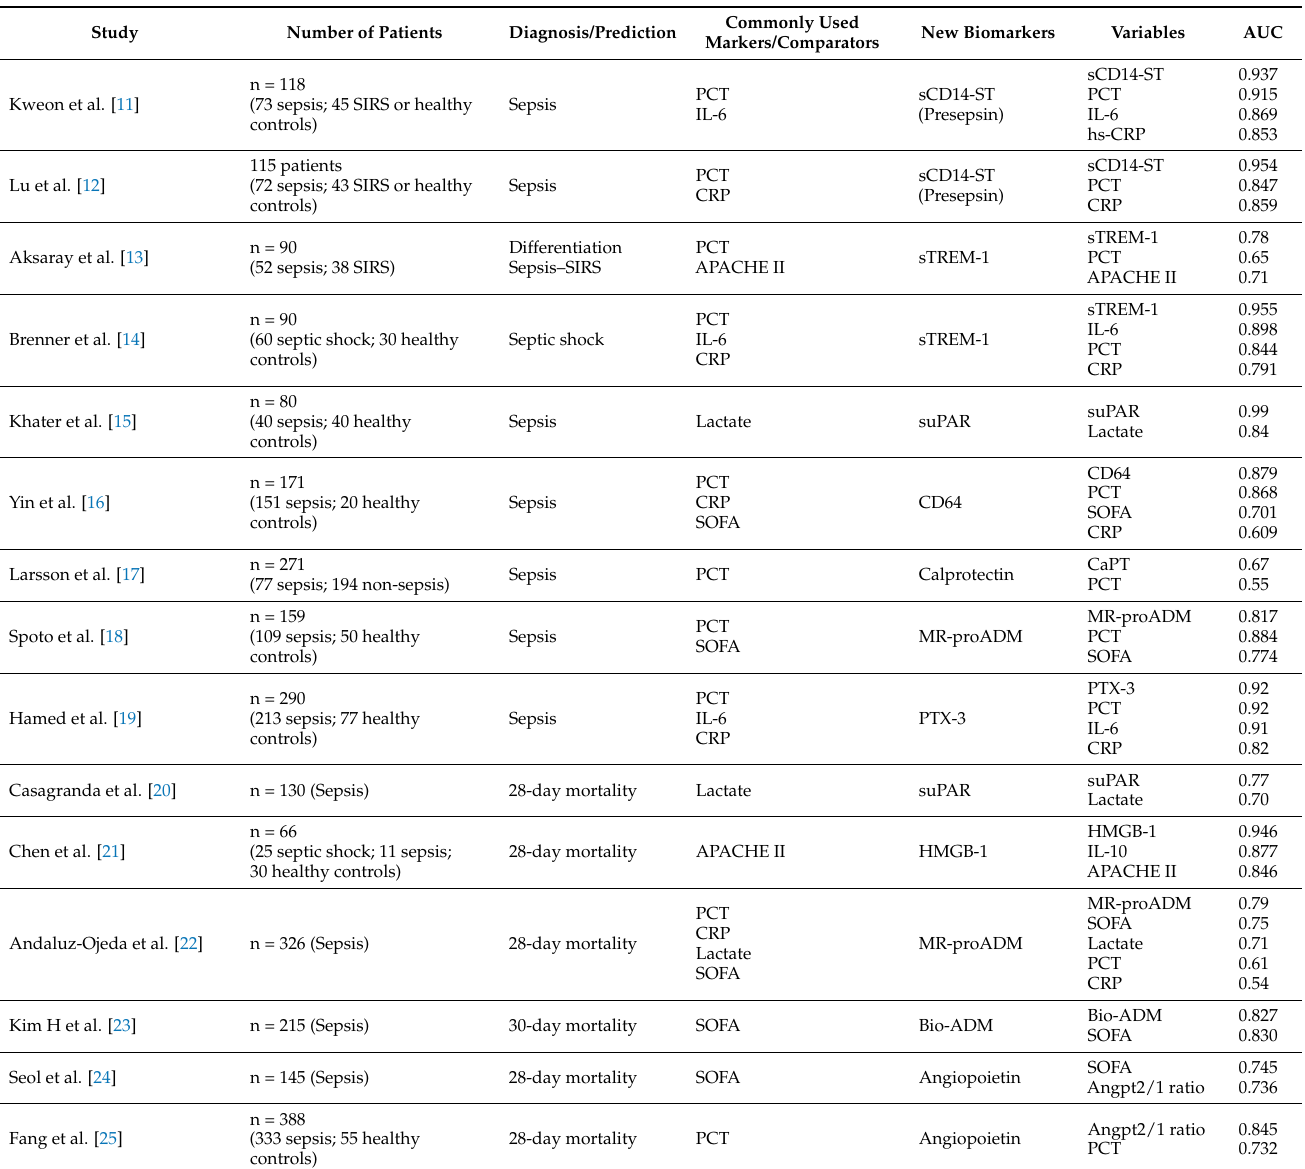
Table 2. Diagnostic and prognostic biomarkers of sepsis. Angpt2/1, Angiopoietin 2/Angiopoietin 1; APACHE, Acute Physiology And Chronic Health Evaluation; AUC, Area under the curve; Bio- ADM, Bioactive Adrenomedullin; CaPT, Calprotectin; CRP, C-reactive protein; HMGB-1, High- mobility group protein B1; hs-CRP, high-sensitivity C-reactive protein; IL-6, Interleukin-6; MR- proADM, Mid-regional proAdrenomedullin; PCT, procalcitonin; PTX-3, Pentraxin-3; sCD14-ST, soluble CD14 subtype; SIRS, systemic inflammatory response syndrome; SOFA, Sepsis-related organ failure assessment; sTREM-1, soluble triggering receptor expressed on myeloid cells-1; suPAR soluble urokinase-type plasminogen activator